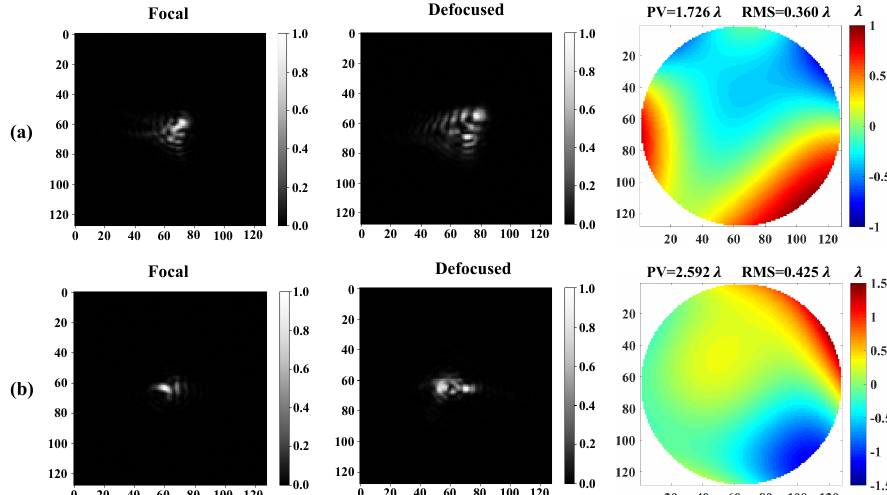
Figure 2. The example of data set. ( a , b ) the example of two pairs of the focal and defocused images and their corresponding phase map obtained by the Zernike coefficients. The pixel value of the focal and defocused images have been normalized to 0–1 before inputting to the neural network and the size of images is 128 × 128. The unit of phase map is λ